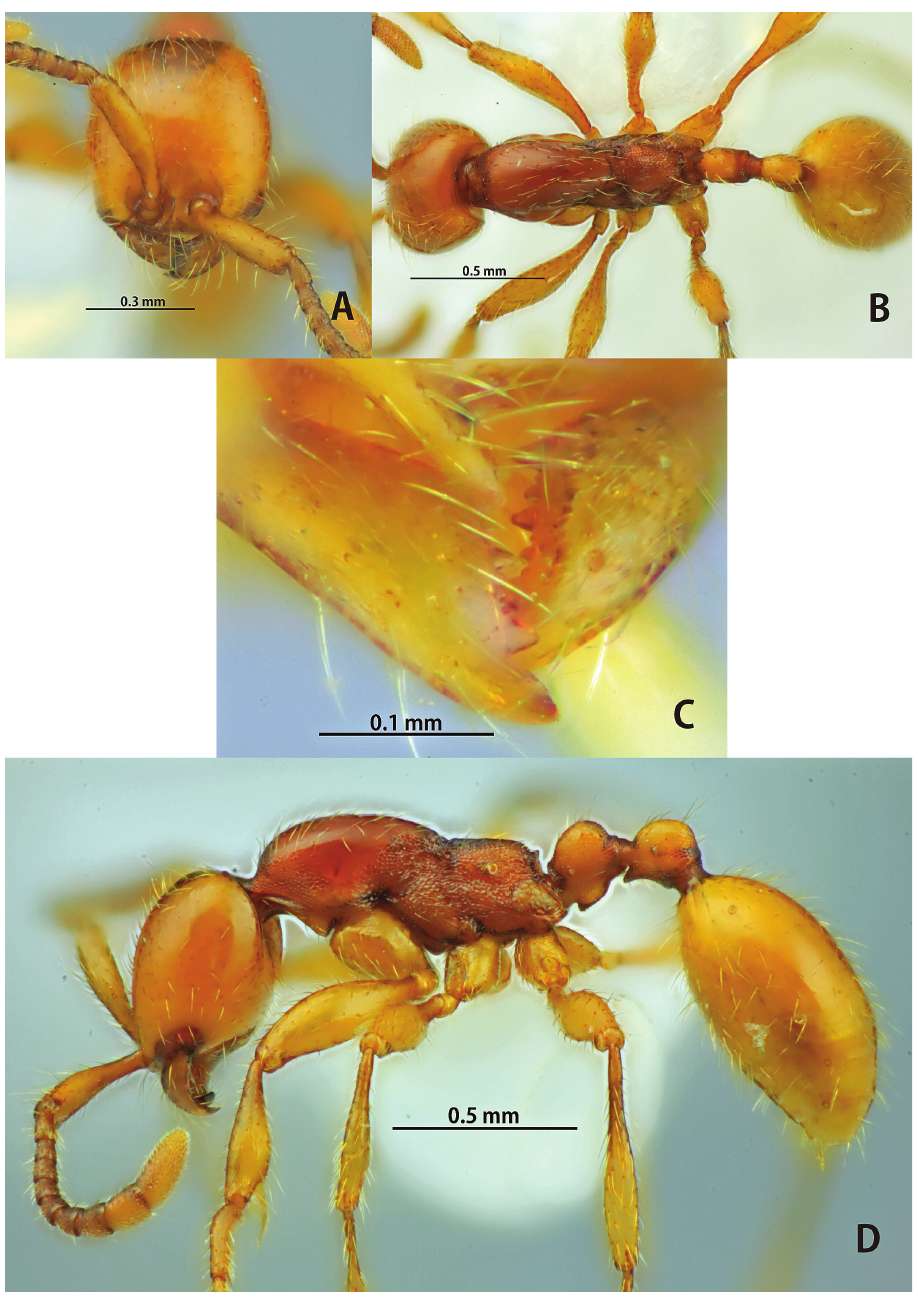
Figure 11. Aenictus lifuiae (paratype). A Head in full-face view B body in dorsal view C mandibles D body in